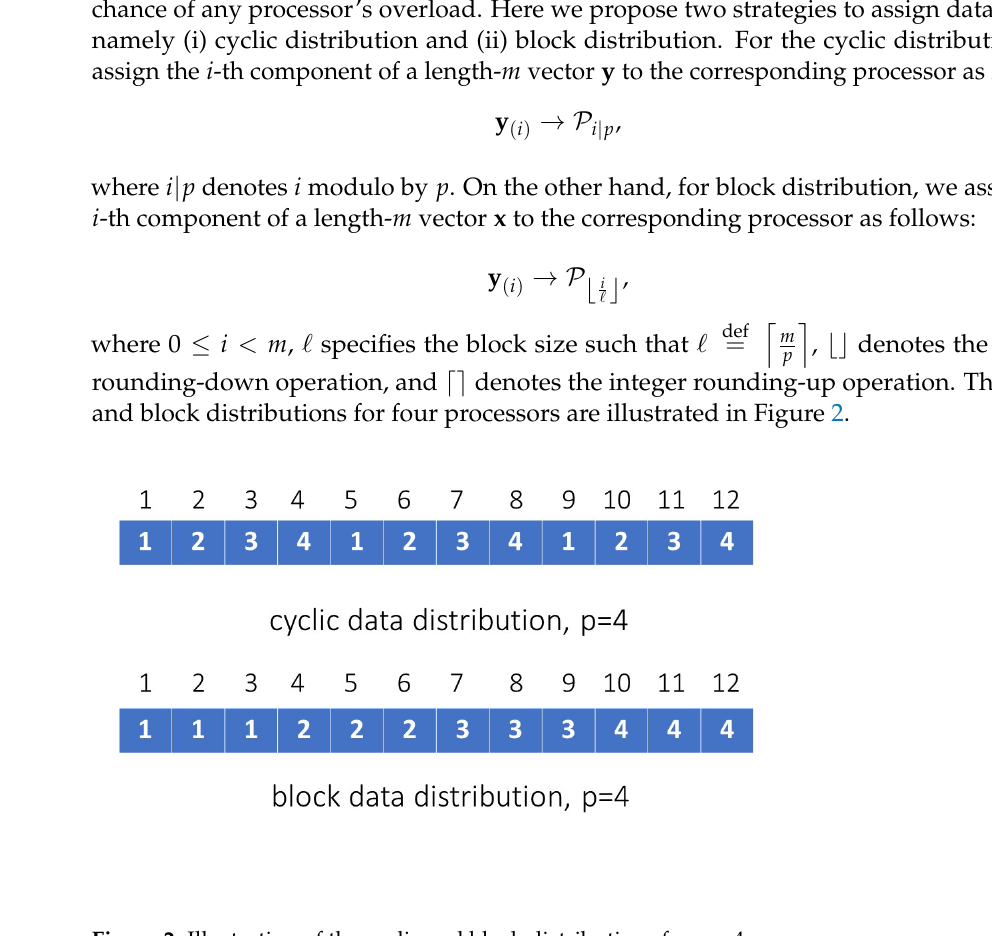
Figure 2. Illustration of the cyclic and block distributions for p =